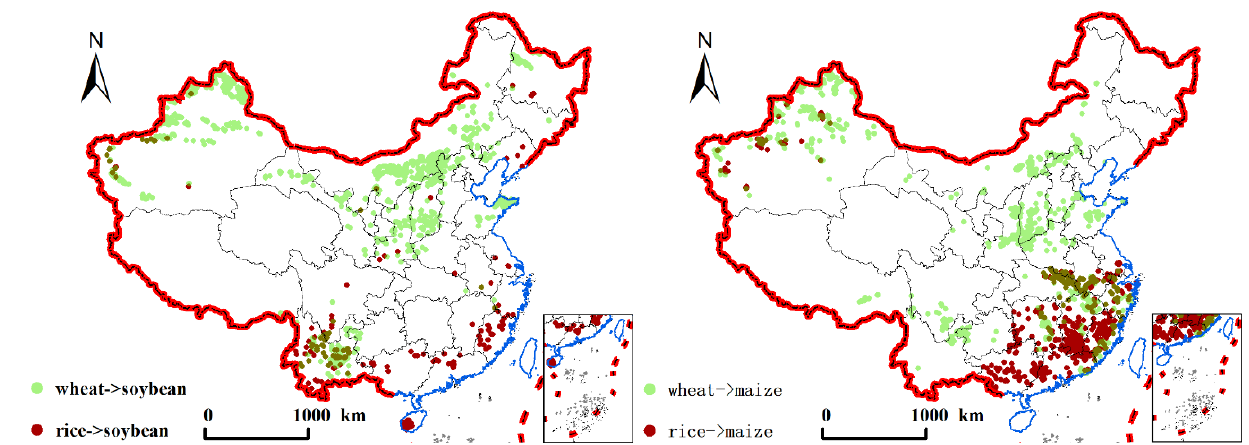
Figure 4. Spatial layout optimisation schemes from food grain to feed grain.